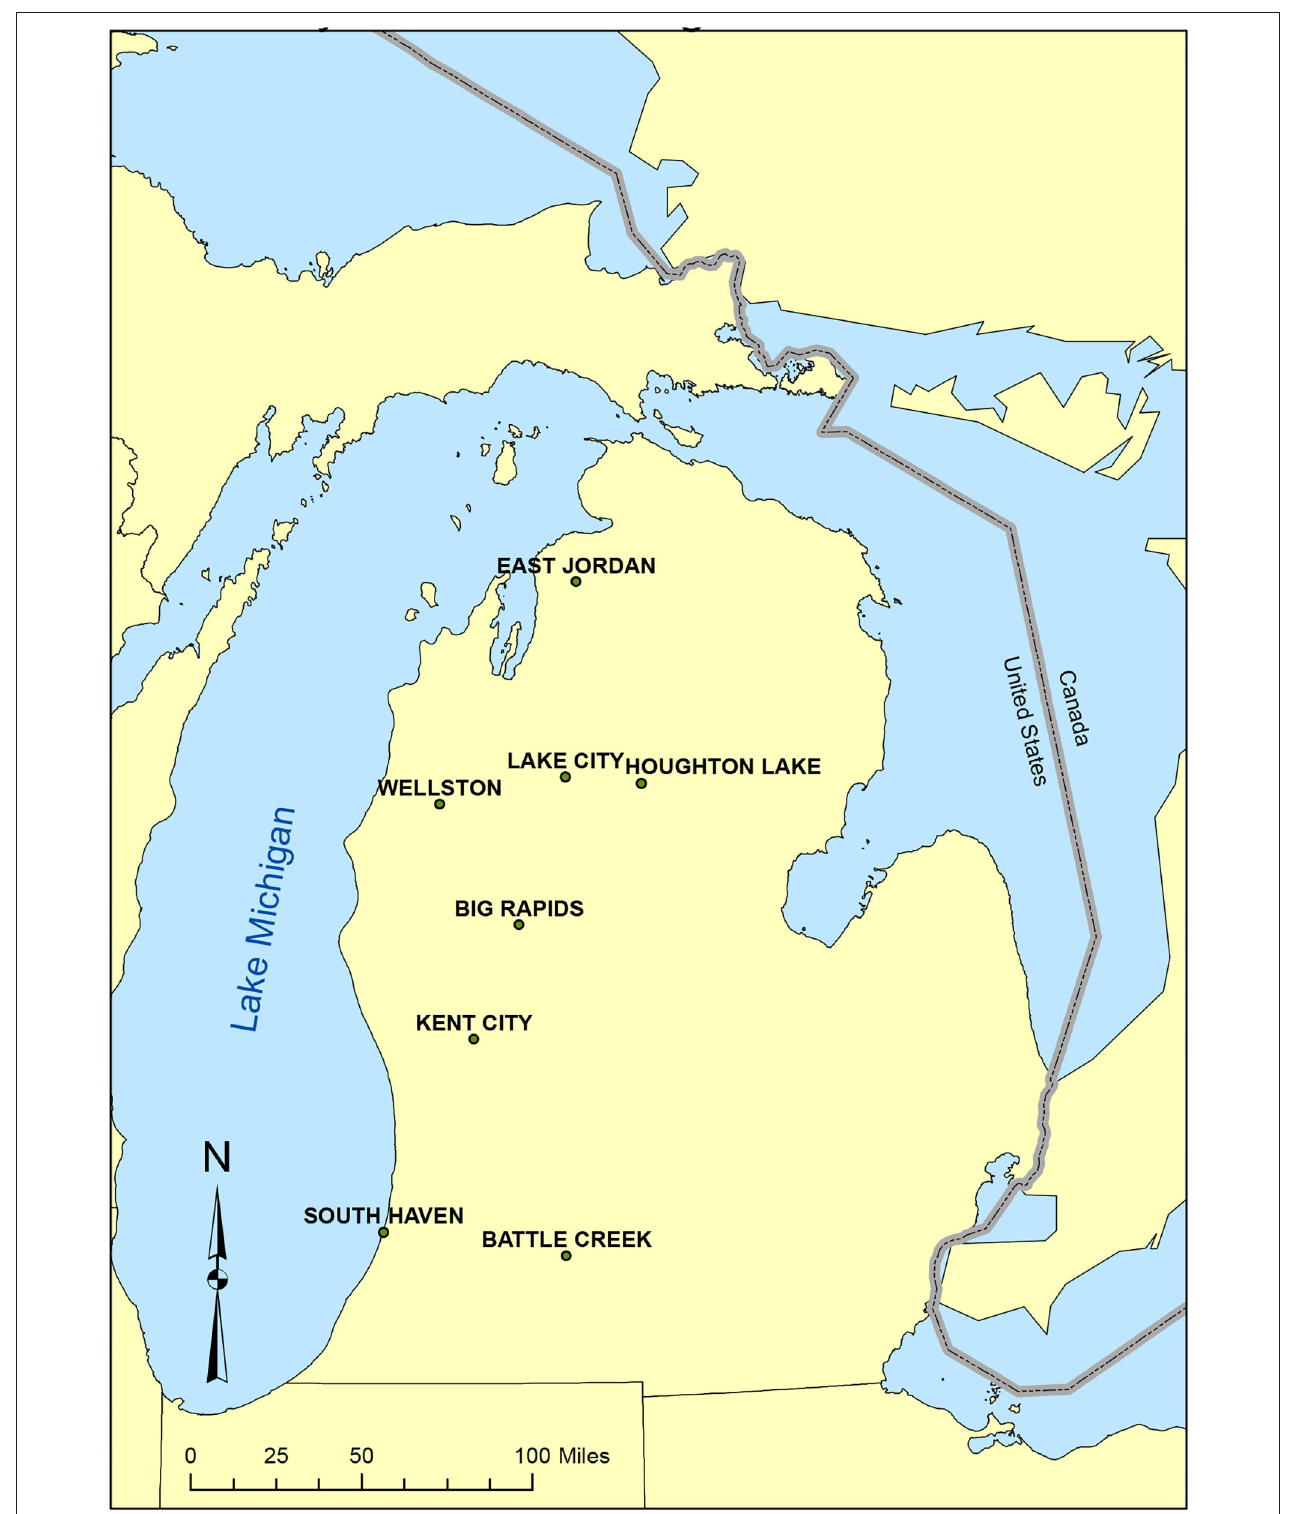
FIGURE 1 | The study area and the location of the eight Cooperative Observer Network (COOP) weather stations. These eight COOP stations are temporally homogeneous stations defined based on the criteria used in Kunkel et al. (2009).